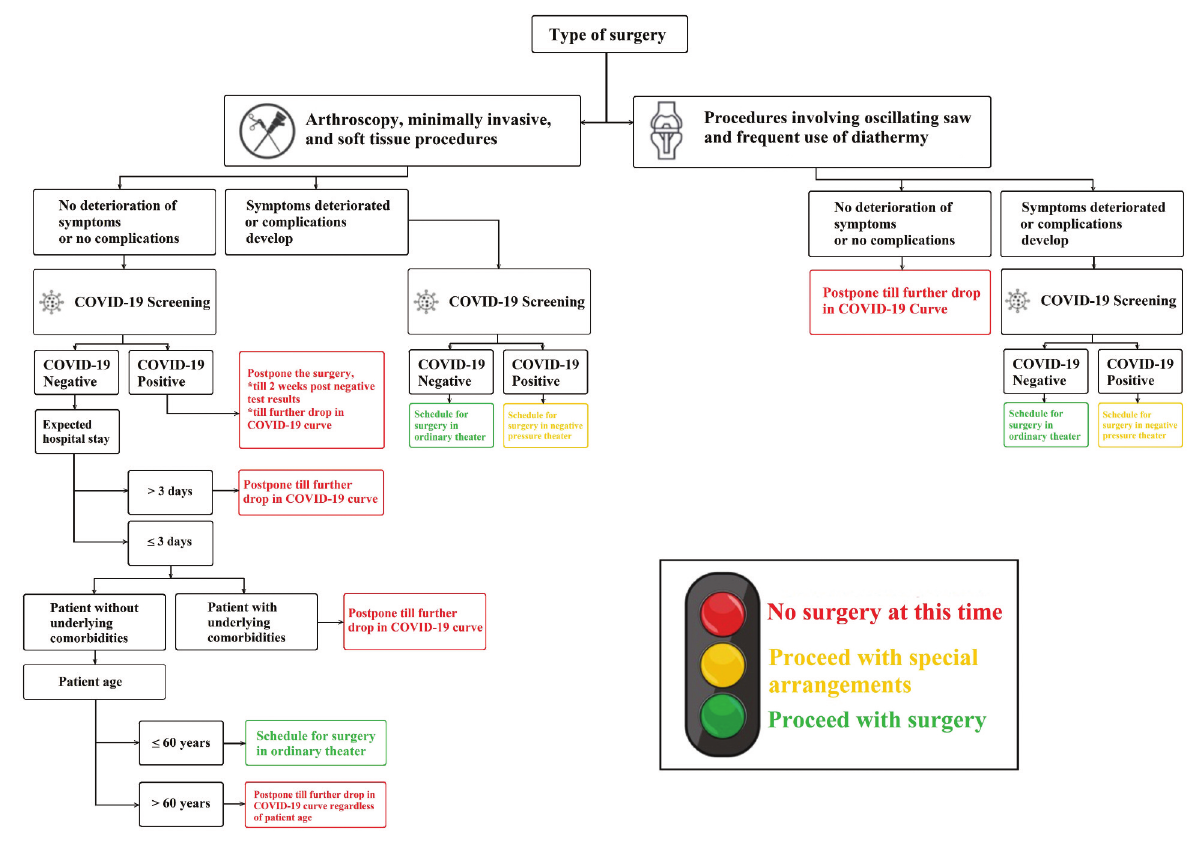
A simple traffic light system to aid in patient selection for elective orthopaedic surgery amid COVID-19 Fig. 1: